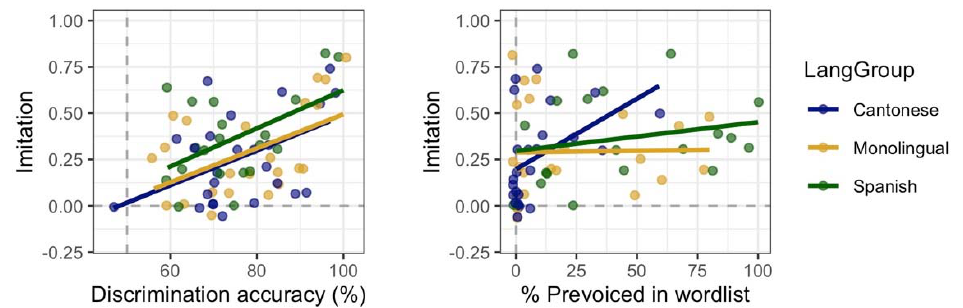
Figure 6. Mean by ‐ participant imitation values, as predicted by individual discrimination accuracy ( left ) and baseline prevoicing (percentage of tokens produced with prevoicing in the English wordlist, right ), with the best ‐ fit regression line for each language group. Points are jittered for readability.